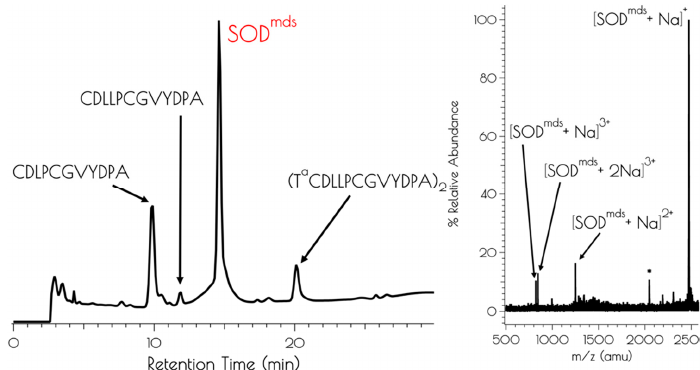
Figure 1. Left: Analytical HPLC chromatogram of the crude mixture resulting from the synthesis of SOD mds with a detector cutoff of 0 intensity units. Identifiable products are highlighted. A mobile phase of a mixture of 0.1% TFA in water and 0.1% TFA in acetonitrile and a linear gradient of 9:1 water:acetonitrile–4:6 water:acetonitrile over the course of 30 min. Right: MALDI-TOF of the purified peptide SOD mds (* indicates [SOD mds ] + with the YDPA residues cleaved from the C-terminus of one of the